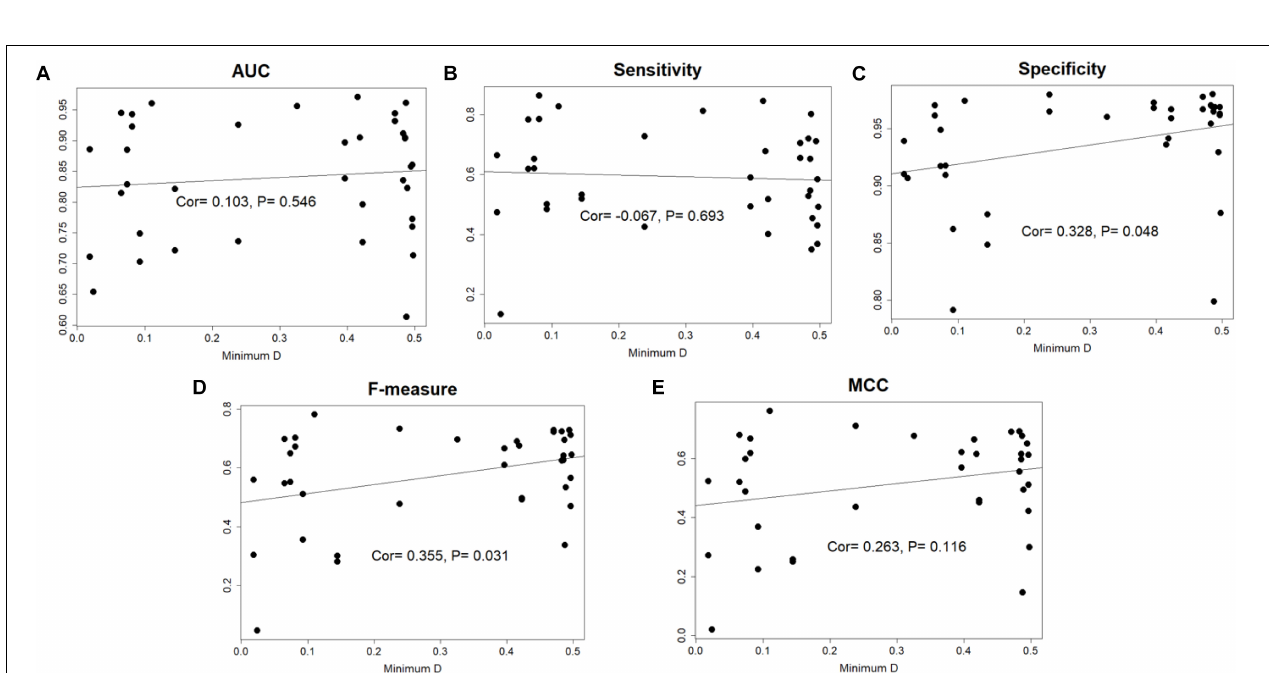
FIGURE 3 | The correlation between minimal species distance and prediction performance among 37 genomes. In each sub-picture, the horizontal axis represents the minimal distance between the query genome and 36 reference genomes. The vertical axis represents the prediction performance estimated by AUC, Sensitivity, Specificity, F-measure and MCC indexes. The “Cor” value in figure is “Pearson correlation coefficient.” (A) The correlation between AUC score and minimal species distance. (B) The correlation between the sensitivity index and minimal species distance. (C) The correlation between the specificity index and minimal species distance. (D) The correlation between the F-measure index and minimal species distance. (E) The correlation between MCC index and minimal species distance.